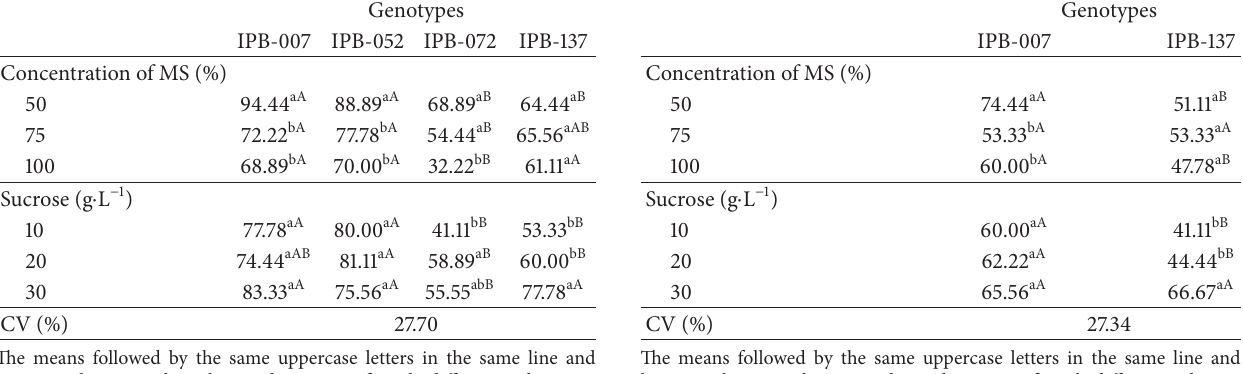
Table 4: Survival of sweet potato microplants at 180 days of in vitro conservation under 18 ∘ C compared between genotypes and the concentration of MS salts and sucrose.